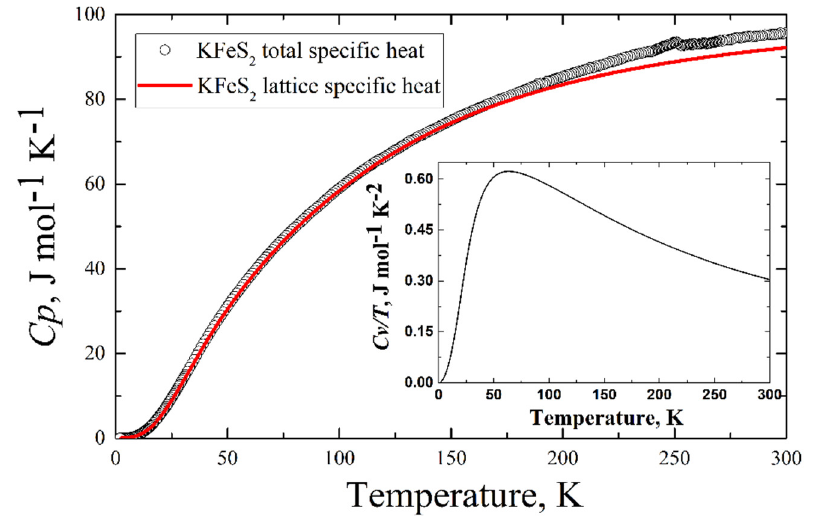
Figure 9. Temperature dependence of the specific heat C P of KFeS 2 (black circles)—experimental data, red line—calculated lattice contribution to the specific heat at constant pressure C P = C V + 0.003 [J/mol K 2 ] T . Inset—the calculated specific heat at constant volume drawn as C V ( T )/ T .